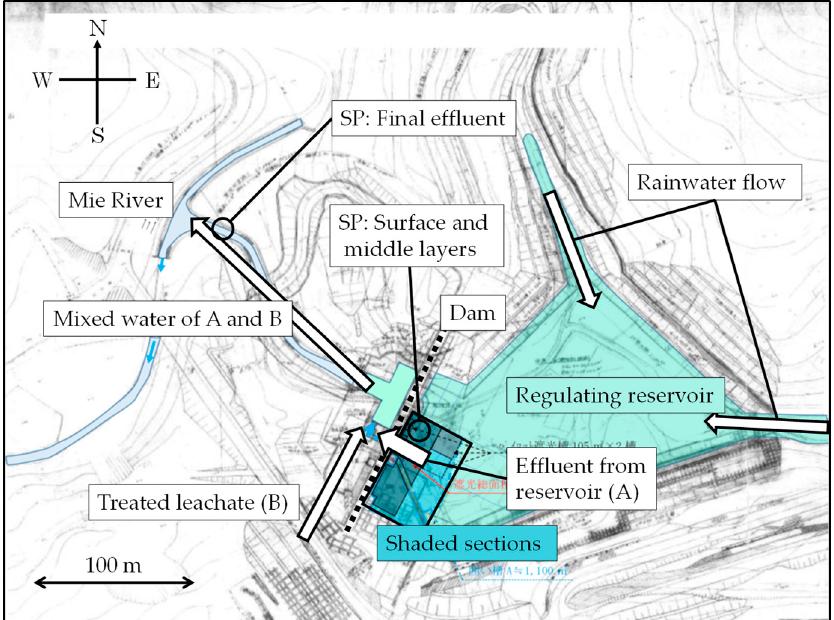
Figure 1. Direction of water flow and water sampling points for regular measurements in Sankyo RRR.